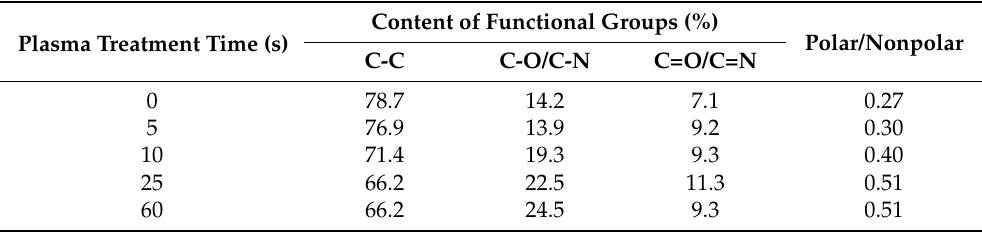
Table 12. Types and corresponding contents of surface functional groups of CF/EP samples with different plasma treatment